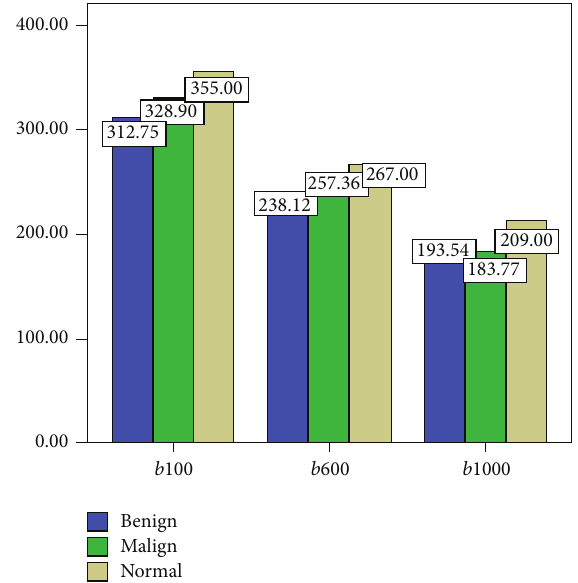
Figure 3: Comparison of parenchymal ADC values of obstructed kidneys with benign-malignant etiology and normal kidneys, for b 100, b 600, and b 1000 (mm 2